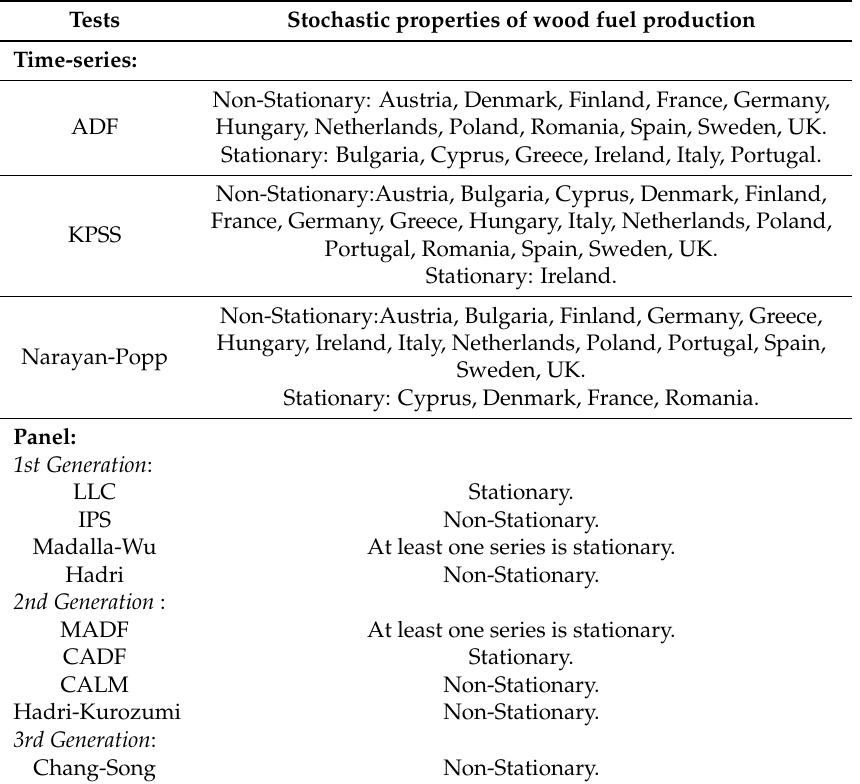
Table 6. Summary of test